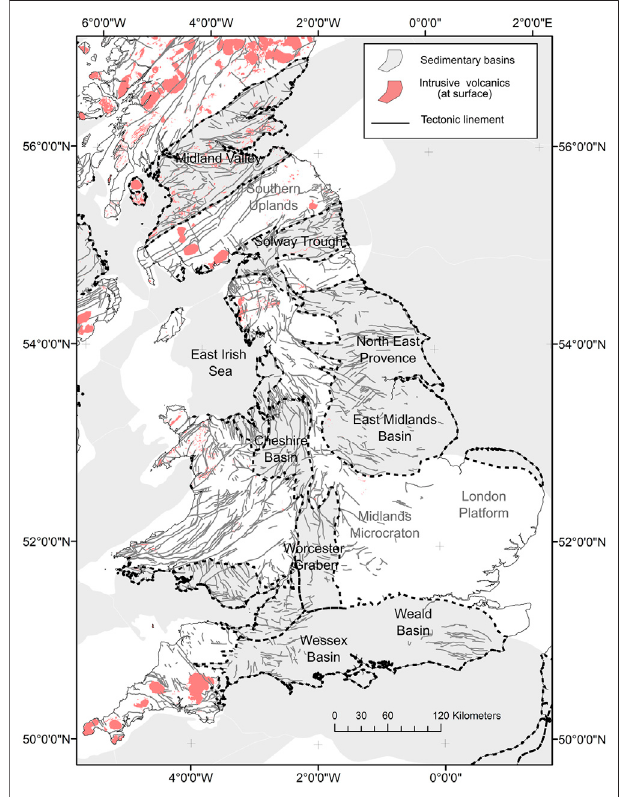
FIGURE 1 | Simpli fi ed geological map of the United Kingdom, showing the outlines of sedimentary basins, position of volcanics at surface, and major tectonic liniments. Incorporates elements of the BGS simpli fi ed geological map downloaded from https://www.bgs.ac.uk/datasets/bgs-geology/ British Geological Survey materials Copyright NERC